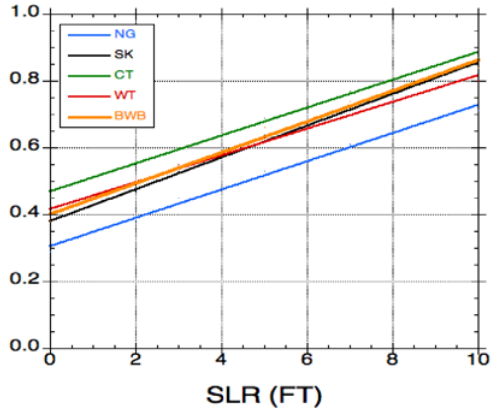
Figure 9. Fraction of houses (%) under 30 ft NAVD88 potentially in harm way (predicted damage larger than 0 %), assuming the most likely scenario for any SLR case between 0 and 10 ft, for Narragansett (NG), South Kingstown (SK), Charlestown (CT), Westerly (WT), and Barrington, Warren, and Bristol (BWB).